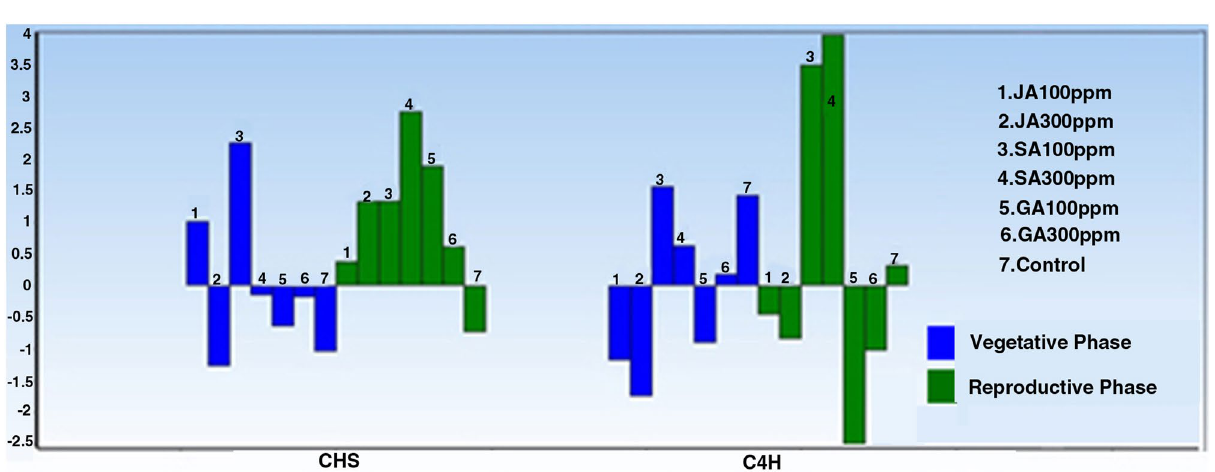
Figure 3. Barplot diagram obtained from T-Test for comparing the expressions of target genes in the aerial part undergone different hormonal treatments at different phenological stages. Accordingly, the diagram obtained for CHS gene shows the increased gene expression in all the treatments performed in the reproductive phase, so that the highest expression level was observed under the SA treatment (300 ppm), and a decrease in the expression was only observed in the reproductive phase in the control group. SA (100 ppm) was found as the most effective treatment on increasing the CHS expression in the vegetative phase. By comparing C4H gene expression diagram in both vegetative and reproductive phases, it was found that different SA concentrations in the reproductive phase have caused a sharp increase in the expression of this gene. Additionally, the diagram obtained for C4H gene shows a decreasing trend under the effect of different concentrations of JA in both vegetative and reproductive measuring the flavonoid content in the aerial part also show the highest and the lowest flavonoid contents at the reproductive growth stage in the SA (300 ppm) concentration and GA (100 ppm) at the vegetative growth stage, respectively. In other words, the flavonoid content in the SA treatment (300 ppm) was about 2.5 times higher than that of the control treatment in the reproductive phase. Overall, the mean flavonoid content in the repro- ductive growth period was observed to be much higher than that of the vegetative phase (Fig. 6). The evaluation of the total flavonols in both control and treated cells of plant showed that the highest and lowest total flavonol